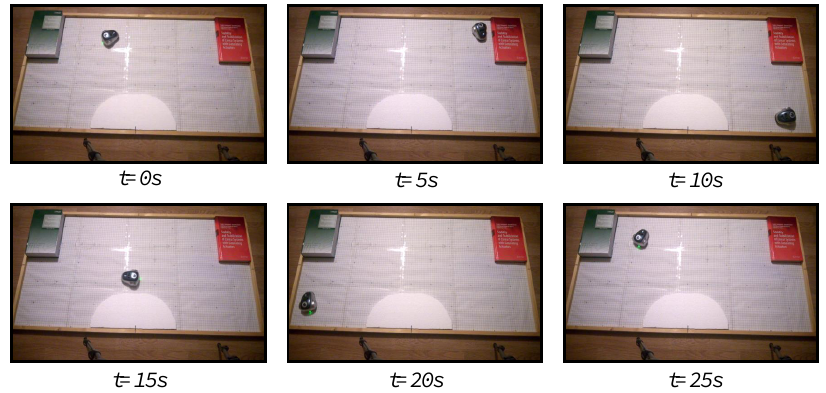
Figure 11. Experiment 2. Wall following algorithm using event-based architecture with ¯ e =